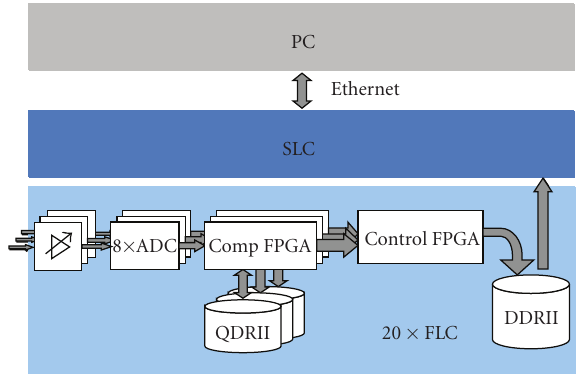
Figure 4: Detailed data-flow of one FLC during the conventional acquisition mode: Every FLC processes 24 receiver channels in par- allel, whereas a group of eight signals is digitized in a single ADC. The digital signals are filtered and averaged in the computing FPGAs. Finally, the signalsare transmitted to the Control FPGA and stored in DDRII